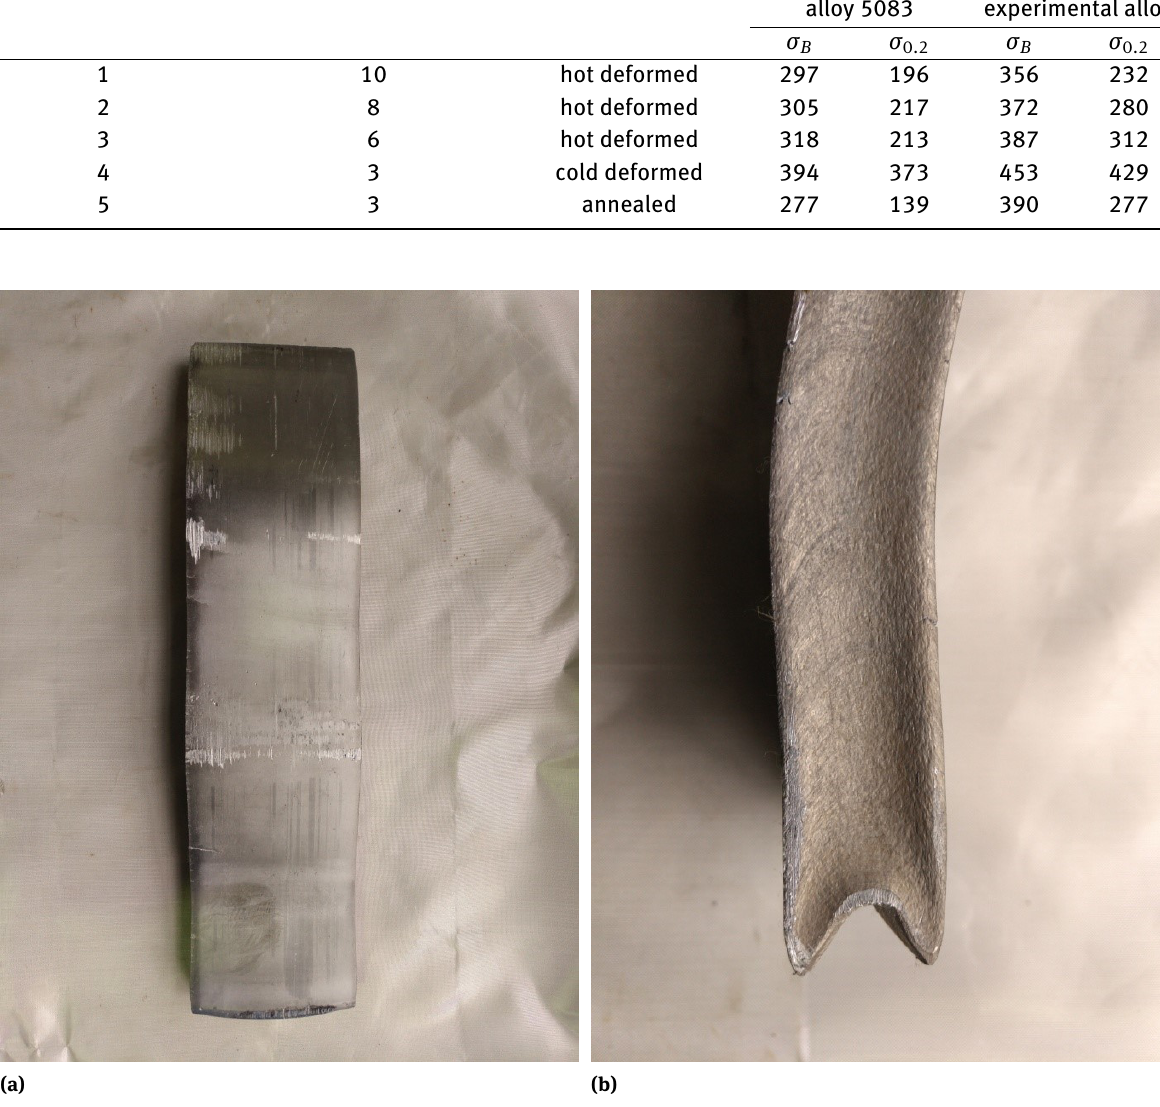
Rolling of the third billet (Figure 6) with a thickness of 40 mm was done with an aluminium cladding of two large facets with a 1 mm thick plate and a length of 0.75 of the sample length at T = 450 ∘ C. The modes of reduction and the temperature of the metal are given in Table 4. The total degree of deformation ϵ t was 75% (final thickness h i = 11 mm), during the rolling process, 4 intermediate tempera- tures of the metal had to be